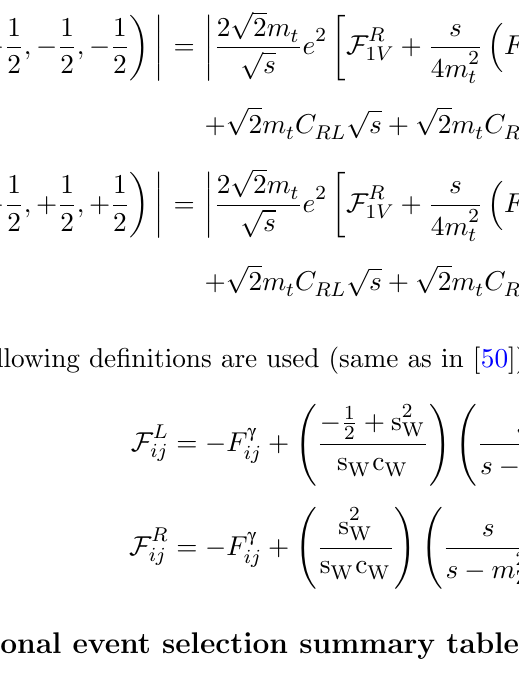
Table 18. Pre-selection and (cid:12)nal event selection e(cid:14)ciencies and expected number of events for the analysis of tt production with radiative events in the interval 400 GeV (cid:20) assuming an integrated luminosity of 2 : 0 ab (cid:0) 1 and 0 : 5 ab (cid:0) 1 for P (e (cid:0) ) = -80% and P (e (cid:0) ) = +80%, respectively.